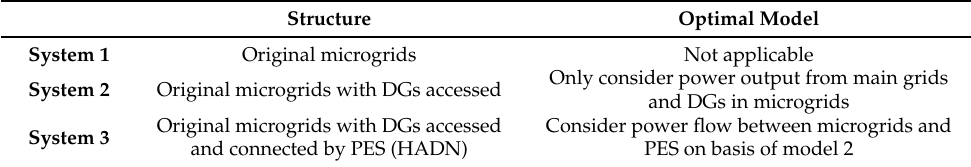
Table 8. Three types of